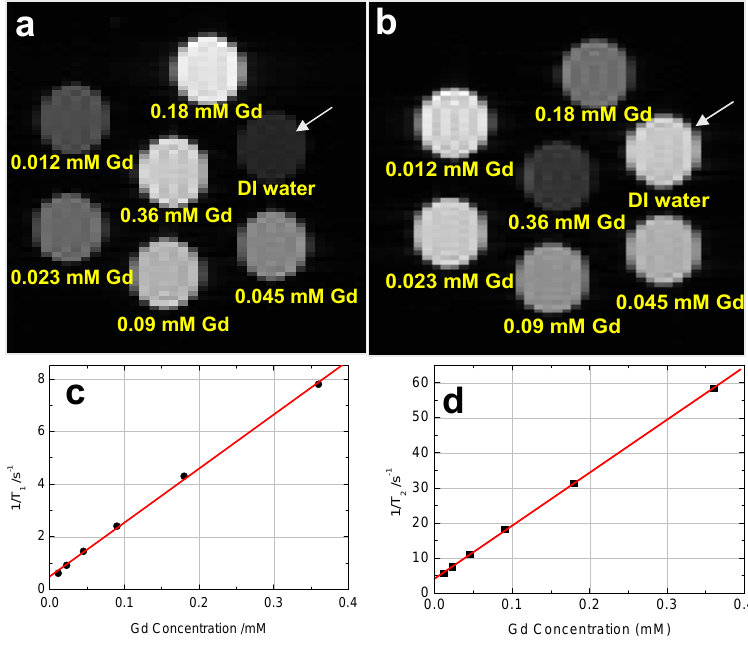
Figure 26. Magnetic resonance data from Gd-functionalized silica-coated CdS:Mn/ZnS Qdots: (a) T -weighted (repetition time (T ) = 11000 ms, echo time (T 1 R = 11000 ms, T = 24 ms) images of deionized (DI) water and serial dilutions weighted (T R E of Gd-functionalized Qdots (0.36, 0.18, 0.09, 0.045, 0.023, 0.012 mM of Gd). Linear plots of Gd concentration versus 1/T (c) and 1/T (d) to obtain ionic relaxivities of R 1 2